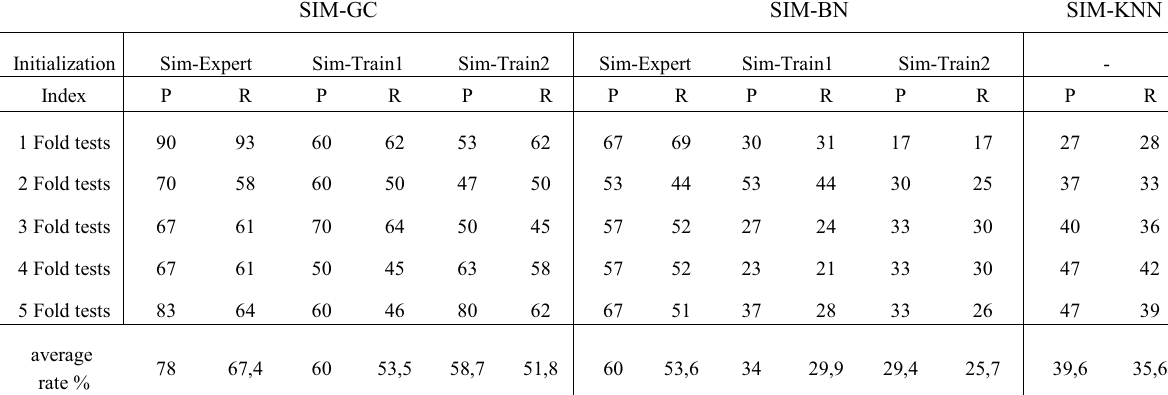
Table 3. Performance rates comparison in terms of precision (P) and recall (R) indices (%) SIM-GC